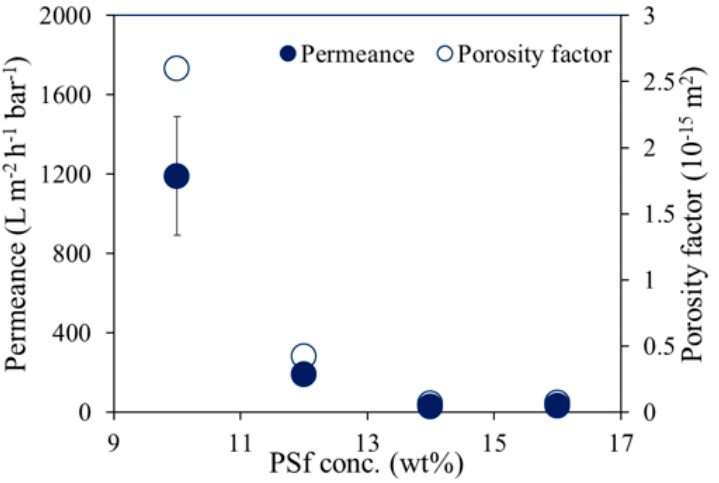
Figure 7. Water permeance and the porosity factors of the UV-cured PSf supports that were prepared using different PSf concentrations, 2 wt% XL, and 0.3 wt% PhIn.